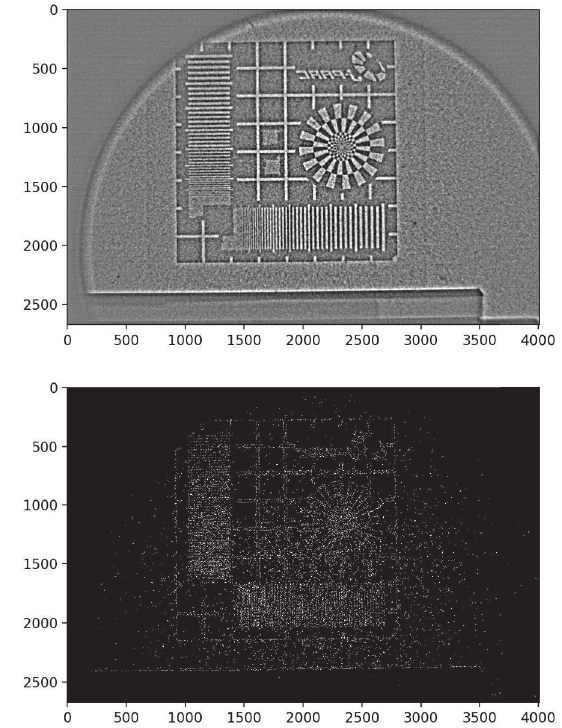
Figure 3. Images before (upper) and after (lower) the Laplacian filter is applied.